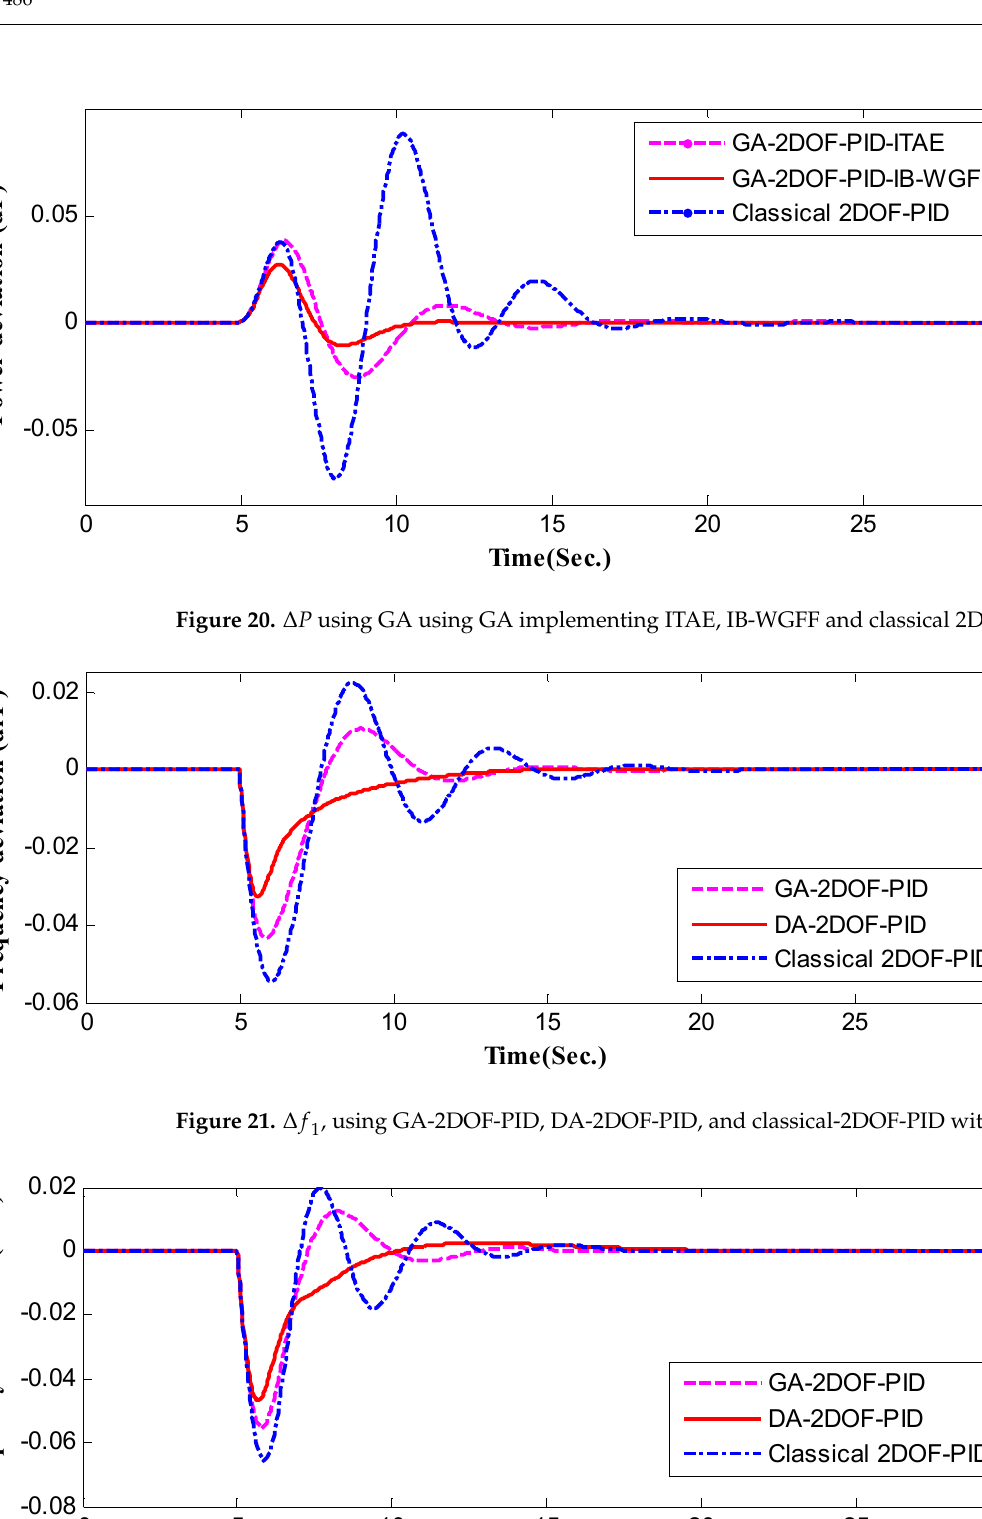
23 of 35 Figure 18. Δf (cid:2869) , using GA implementing ITAE, IB-WGFF and classical 2DOF-PID.